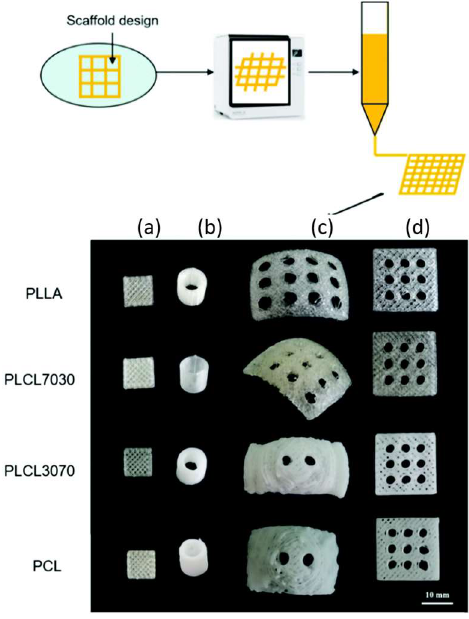
Figure 4. 3D printed micro-structures designed by the computer-aided design model (top) and optical images of different polyester scaffolds. Reprinted with permission from [85].